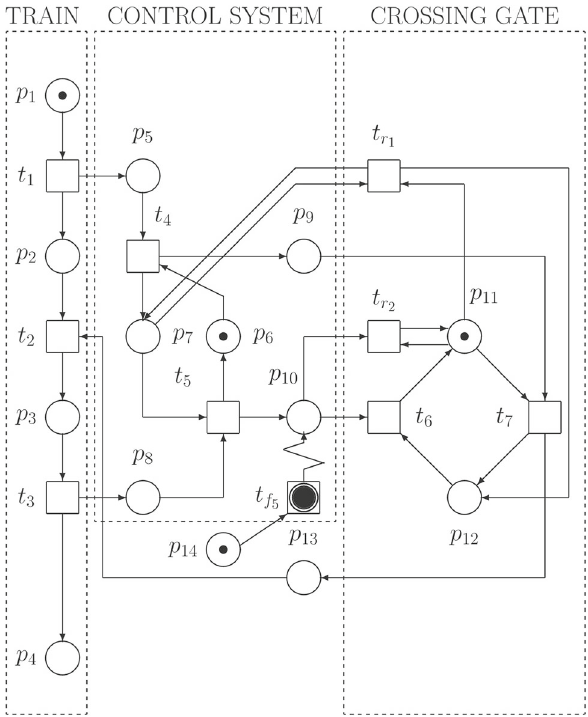
Fig. 6 The PN model of the final recovered